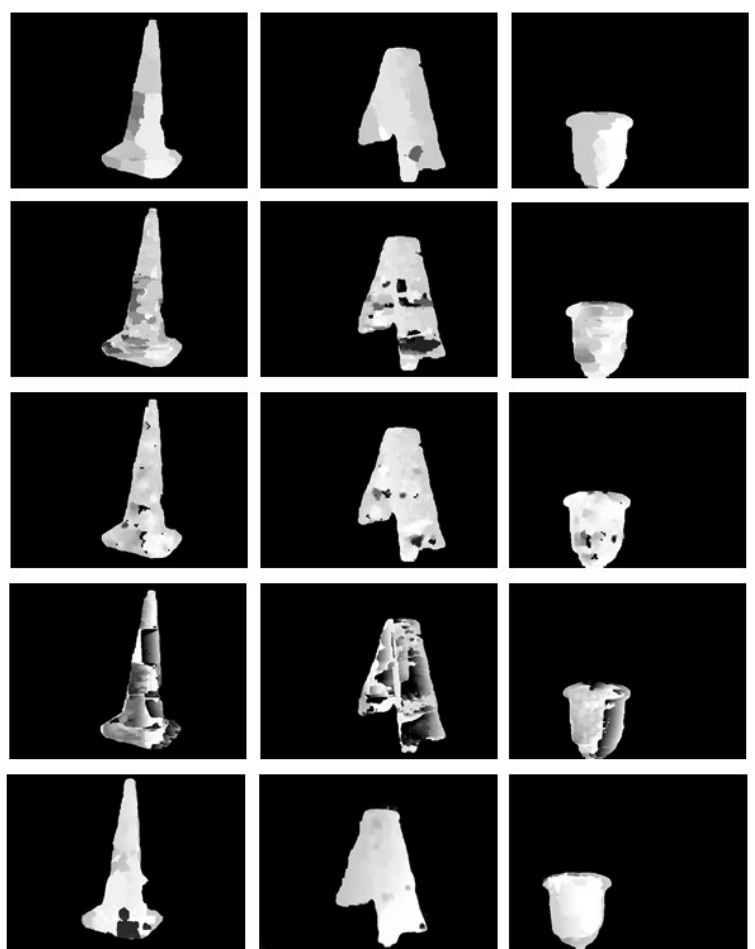
Figure 10. Comparison of the disparity maps produced by the AD-Census method, the FCVF method, the ARWR method, the SGM method and the proposed method, from top to bottom.